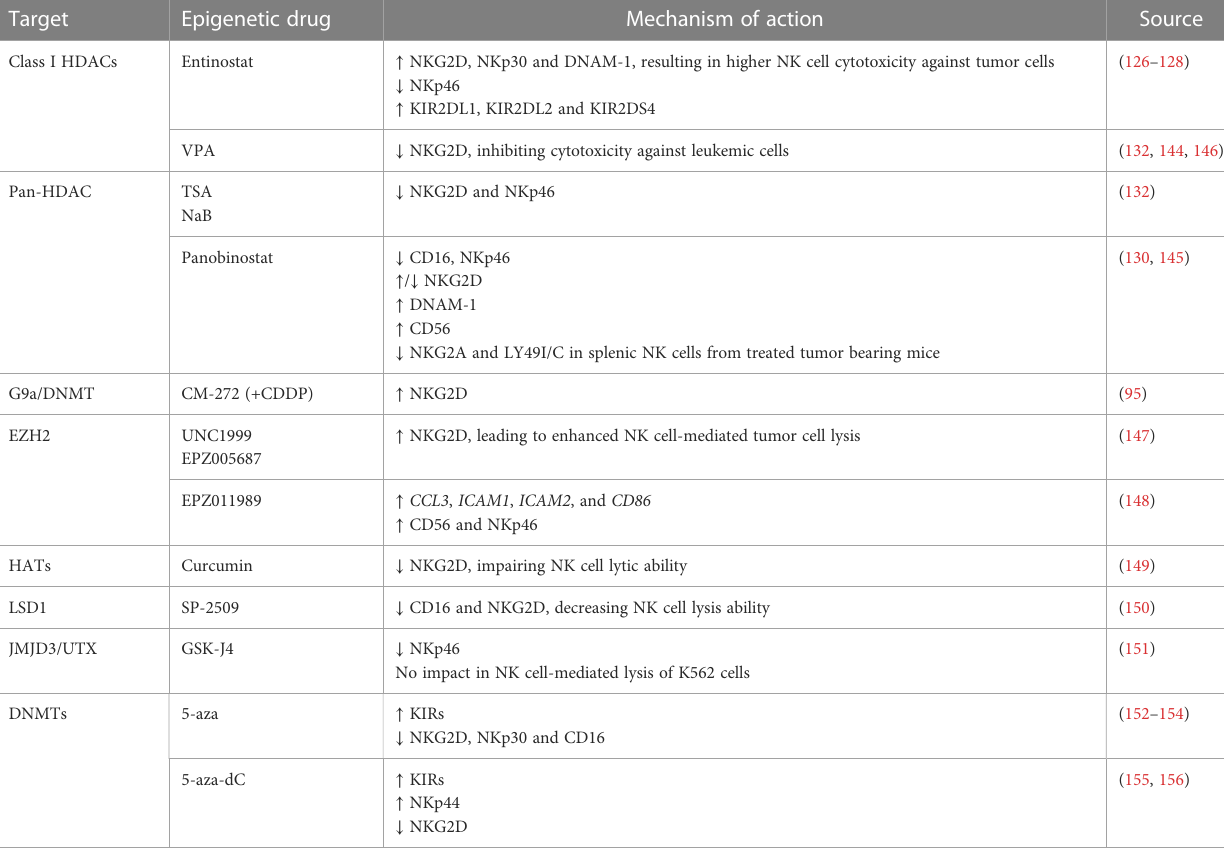
TABLE 3 Modulation of NK cell receptors through treatment with epigenetic modulating